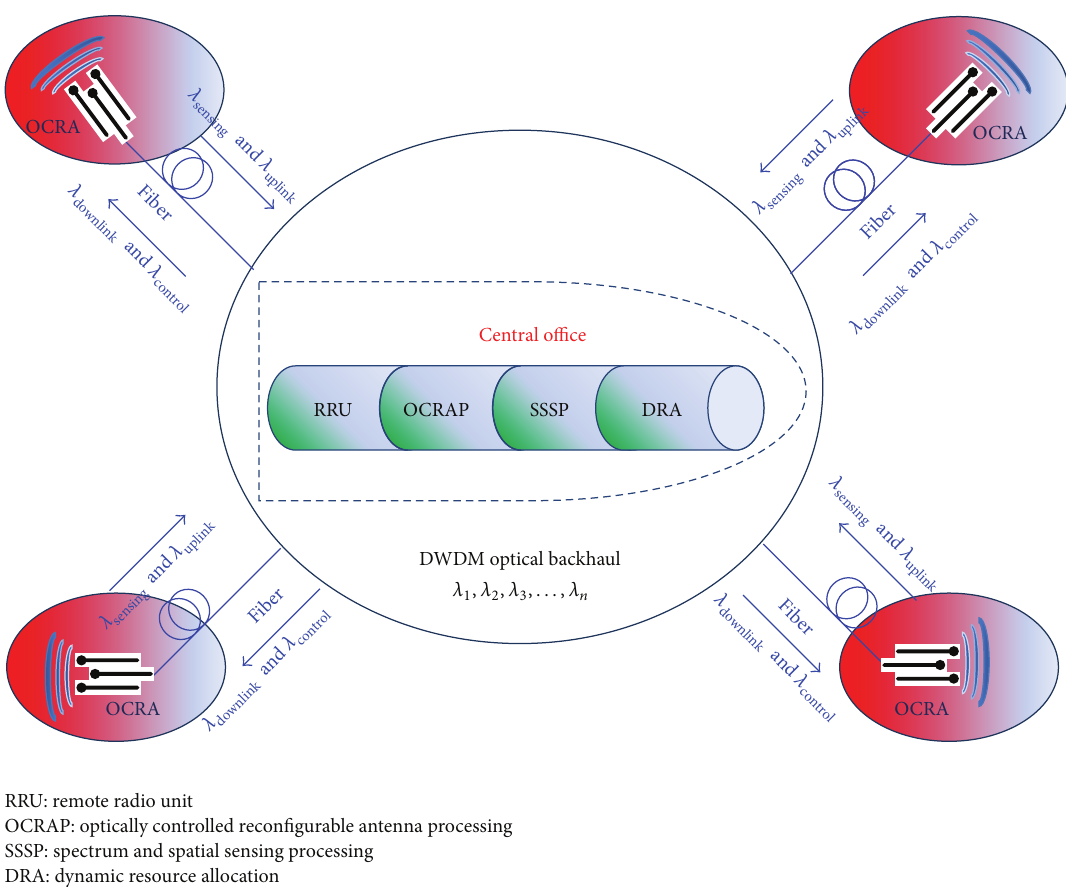
Figure 2: Adaptive and cognitive radio over fiber